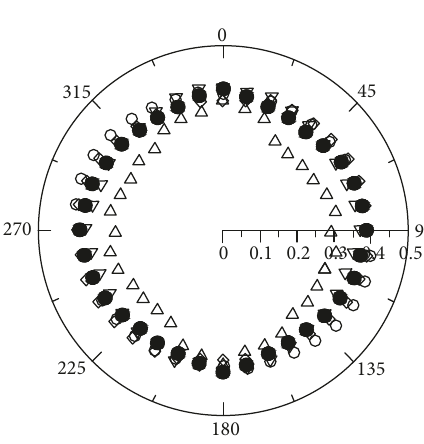
Figure 5: Comprehensive comparison chart of permeability coeffi- cients of the five research areas.